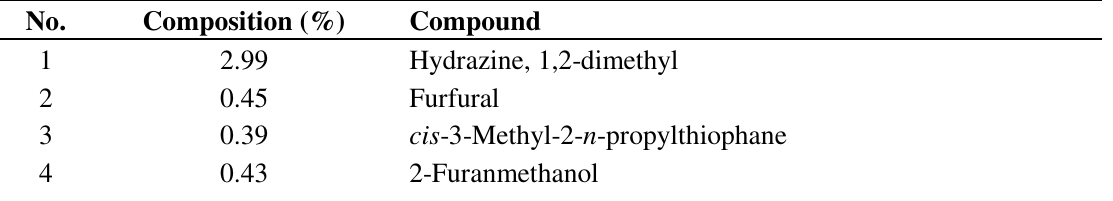
Table 7. Chemical composition of methanolic extraction of L. pumila var.